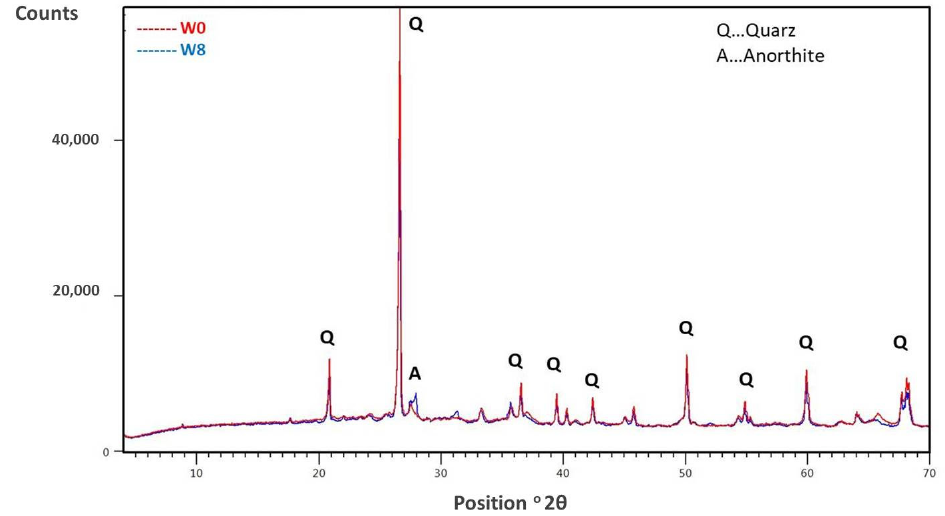
Figure 7. XRD pattern of sample W0 fired at 950 °C and sample W8 (containing 50% sediment) fired at 950 °C.